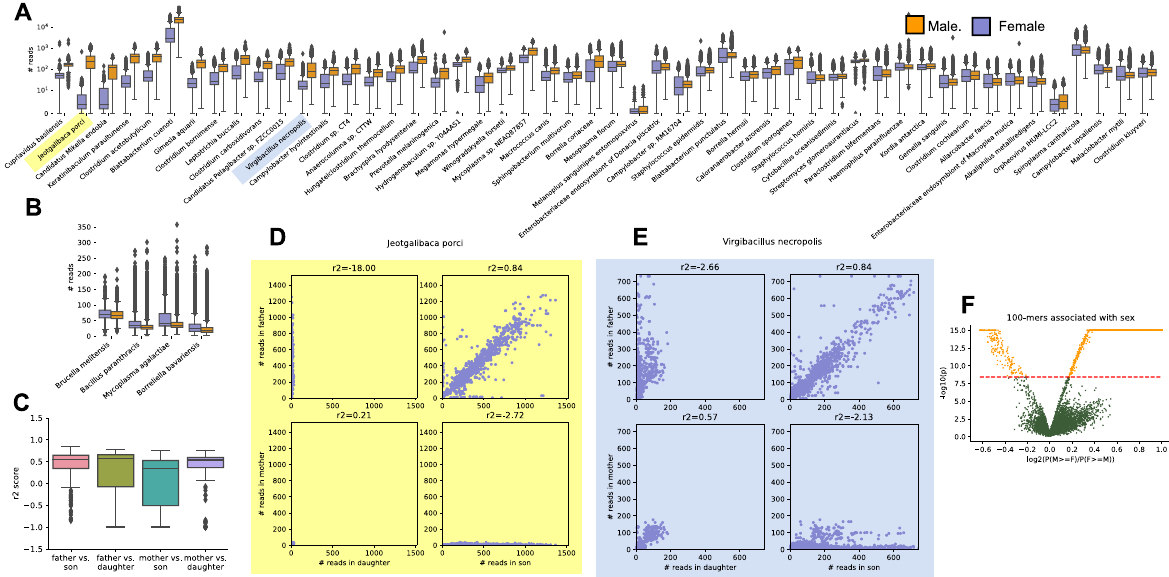
Figure 4. ( A ) Bacteria significantly enriched in males, subsetted to the 50 bacteria with the strongest association. Examples of bacteria with distinct inheritance patterns are highlighted in yellow and blue and shown in D–E . ( B ) Bacteria that were found to be significantly enriched in females (purple). ( C ) Boxplot of correlations between children and parents of different sexes, as measured by the R